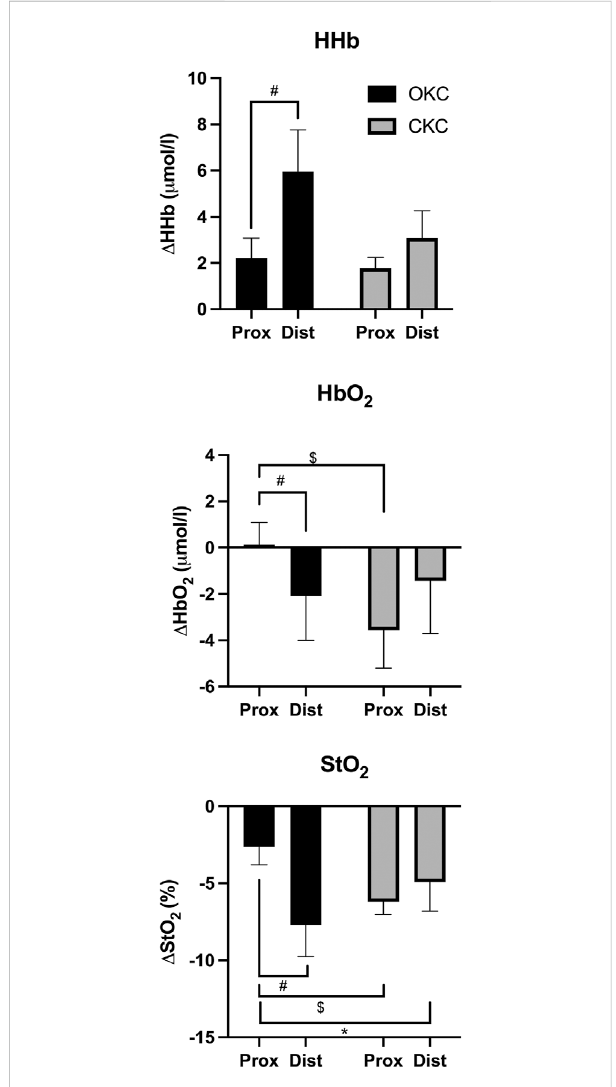
FIGURE 4 Group average ( n = 12) changes in deoxygenated (HHb) and oxygenated (HbO 2 ) hemoglobin concentration and in tissue oxygenation saturation (StO 2 ), during open-kinetic chain (OKC) and closed-kinetic chain (CKC) training sessions. * Mean and standard measurement error are reported with signi fi cant differences ( p ≤ 0.05) between interventions over time (*), between regions for a given exercise (#) and between exercises within a region ($)